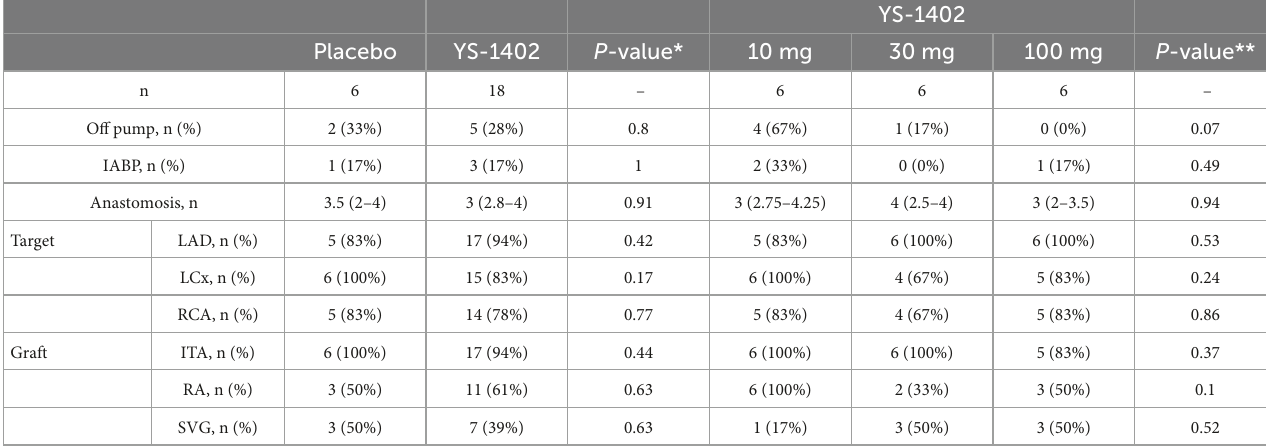
TABLE 2 Operative